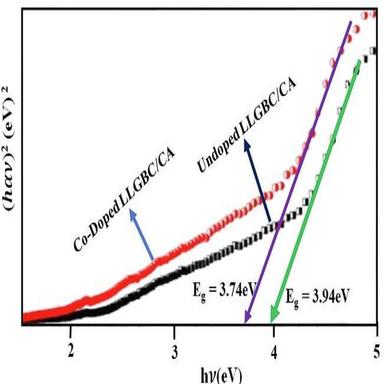
Exposed FTIR spectrum of pure and Co-doping L-LGBCAC. Fig. 5. Exposed Tauc's scheme of undoped and Co-doped LLGBC/CA crystal.